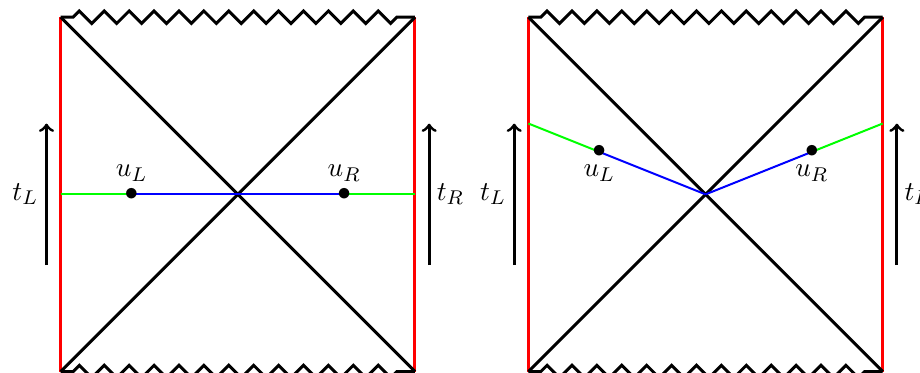
Figure 1 . Two diagrams representing different time slices on the boundary ( ρ = ∞ ) Penrose diagram of the eternal black hole on which the BCFT d lives. The two red vertical lines represent the asymptotic boundaries where we impose conformal boundary conditions. Each time slice is composed of a blue component on one side of the bipartition and a green component on the other side. The green intervals, determined by u L and u R are drawn as equal size here, but generically vary in our setup. The union of the two green intervals is the subsystem we considered in [13] where we computed the entanglement entropy between the green and the blue subsystems. We label time as t L and t R on either side of the diagram, and for both sides we take time evolution to go up the diagram (note the contrast with figure 5). The u -coordinate increases along a given time slice from 0 on the red boundary to u H at the bifurcation horizon, where the black diagonal lines cross. At the jagged singularities, u = ∞